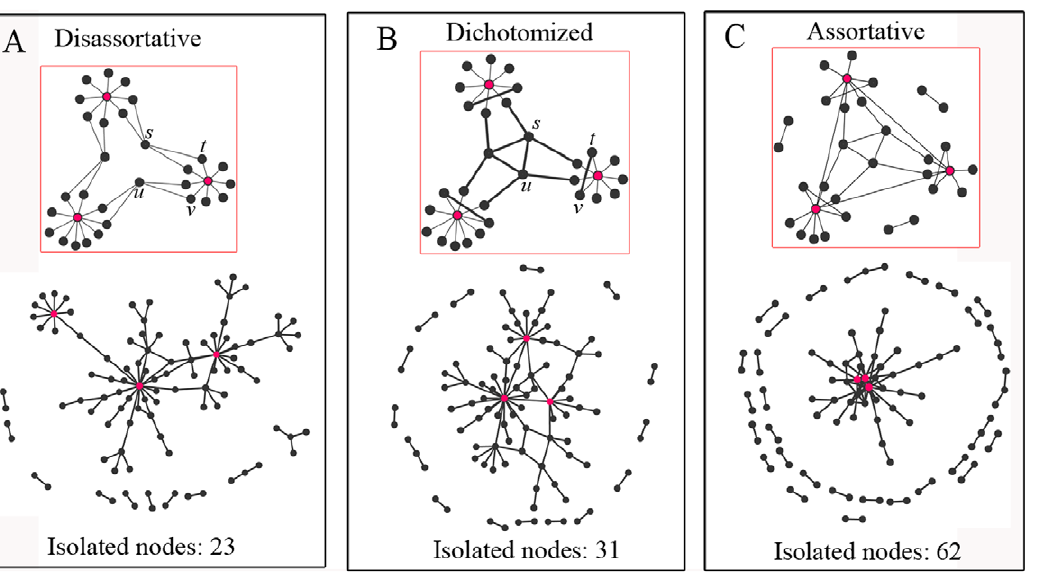
Figure 7. Schematic models of disassortative, dichotomized and assortative networks. A . Schematic model of a disassortative network (inset) and a random network under the principle of the model. B . The same as A but for dichotomized network. C . The same as A but for assortative network. Each of the random networks has the same number of nodes (100), the same number of edges (94) and the same degree distribution. Disassortative network model in A suggests a modular structure with modules separately distributed and pair-wisely connected, whereas C suggests a highly integrated network with nodes integrated by a core of fully connected hubs. The dichotomized network in B suggests a centrally connected modular structure where modules are tightly connected to each other rather than dispersedly distributed.